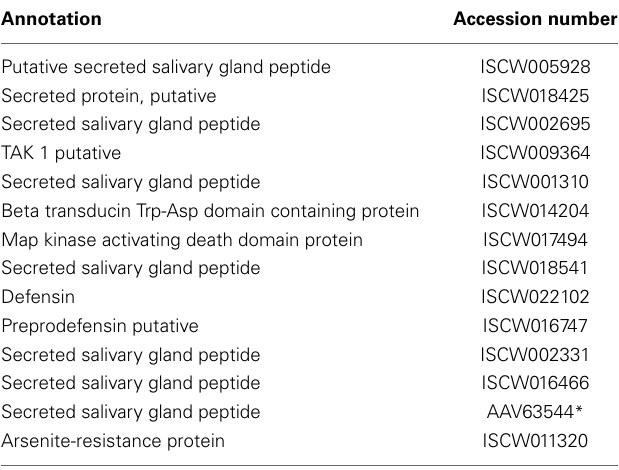
Table 9 | Antimicrobial